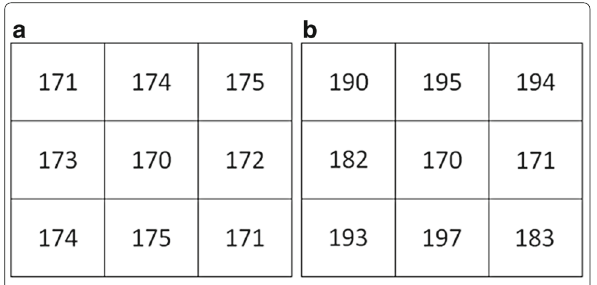
Fig. 2 Example of two different textures which are encoded as same pattern by LBP, a small and b large